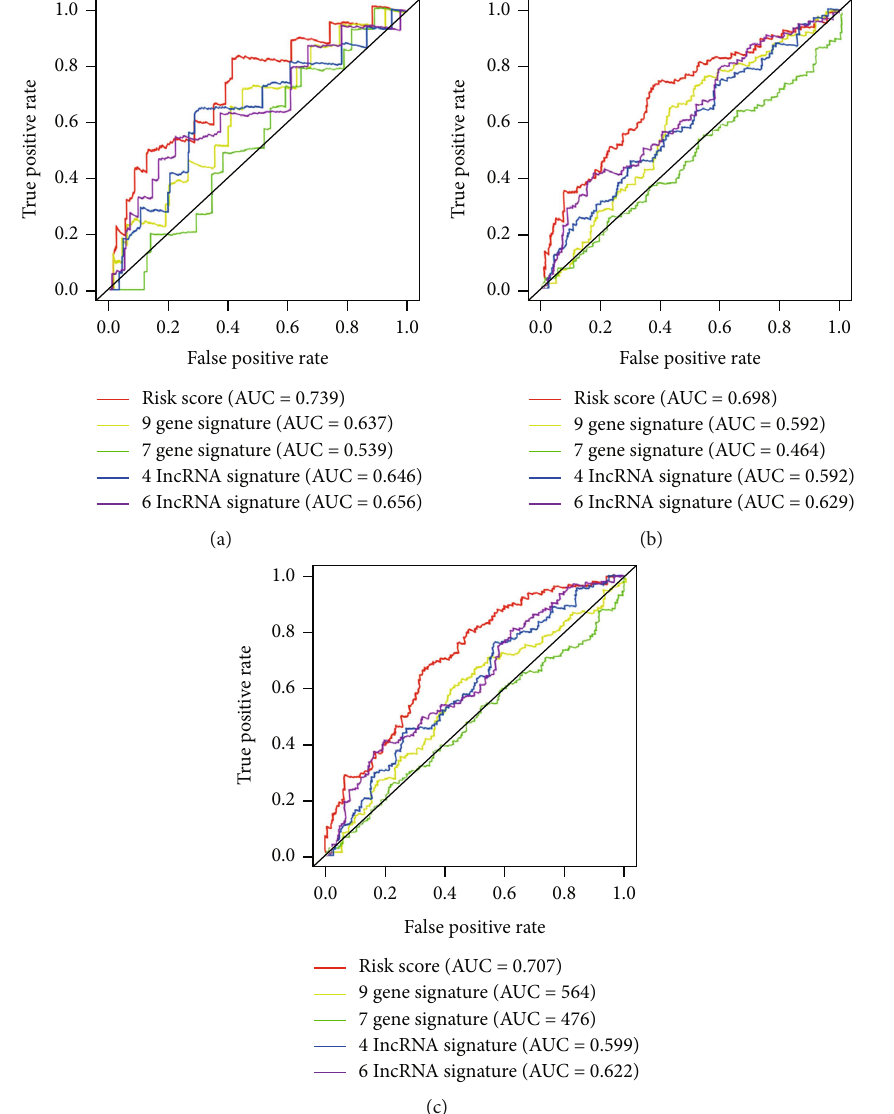
Figure 4: The AUC value for 1-year, 3-year, and 5-year OC of our six-IAG signature compared with other four gene-associated